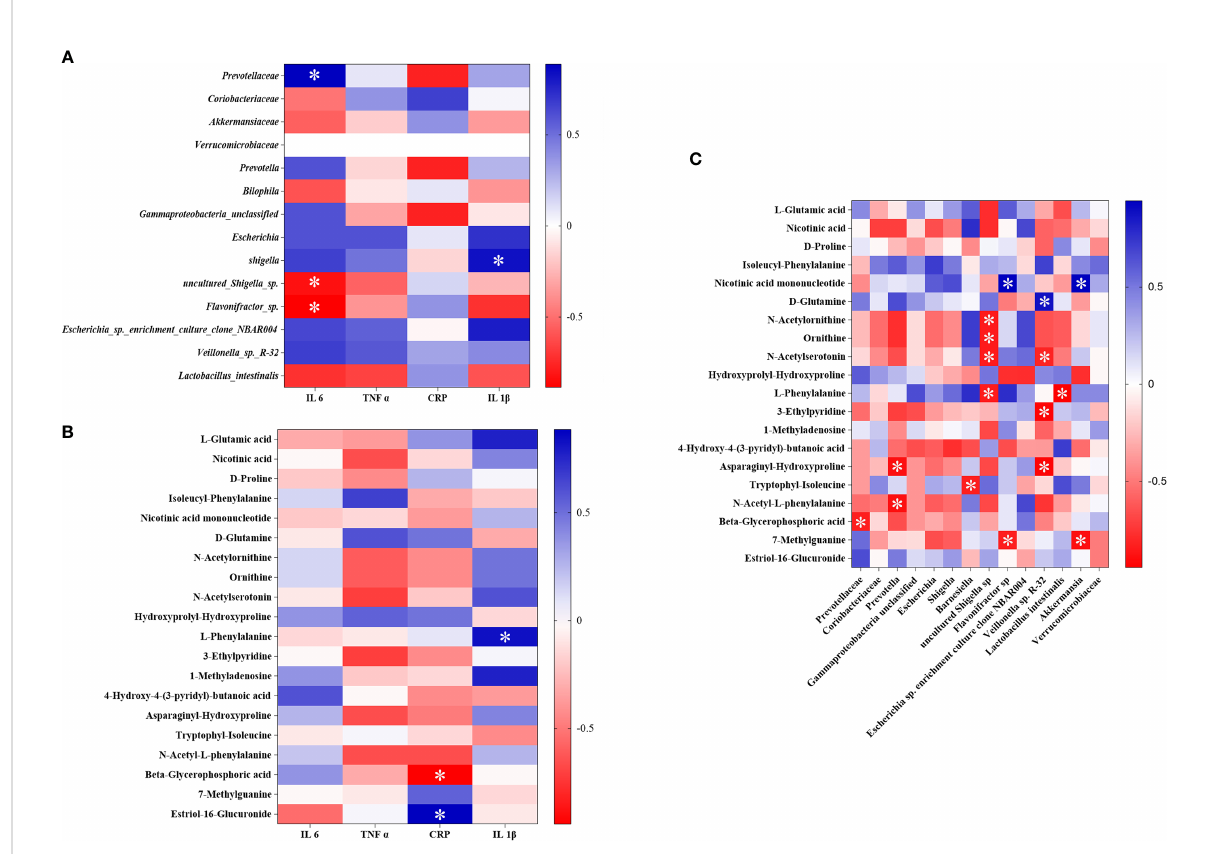
FIGURE 11 The association heat map of correlation for reversed intestinal fl ora and in fl ammatory factors (A) , potential biomarkers and in fl ammatory factors (B) , and intestinal fl ora and potential biomarkers (C) . * P <